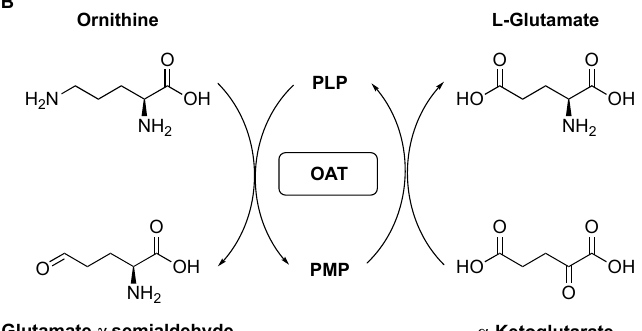
Figure 1. Coupled transamination reactions of GABA-AT ( A ) and OAT ( B ). To date, vigabatrin (VGA, γ -vinyl-GABA, Scheme 1) is the only FDA-approved